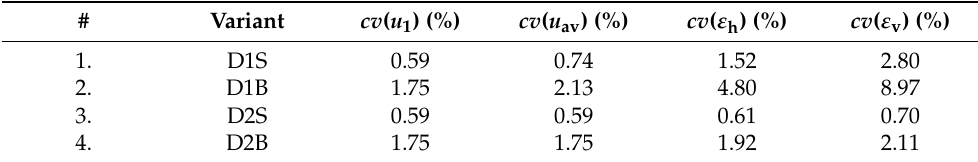
Table 3. Variation coefficient of deflection values and key strains